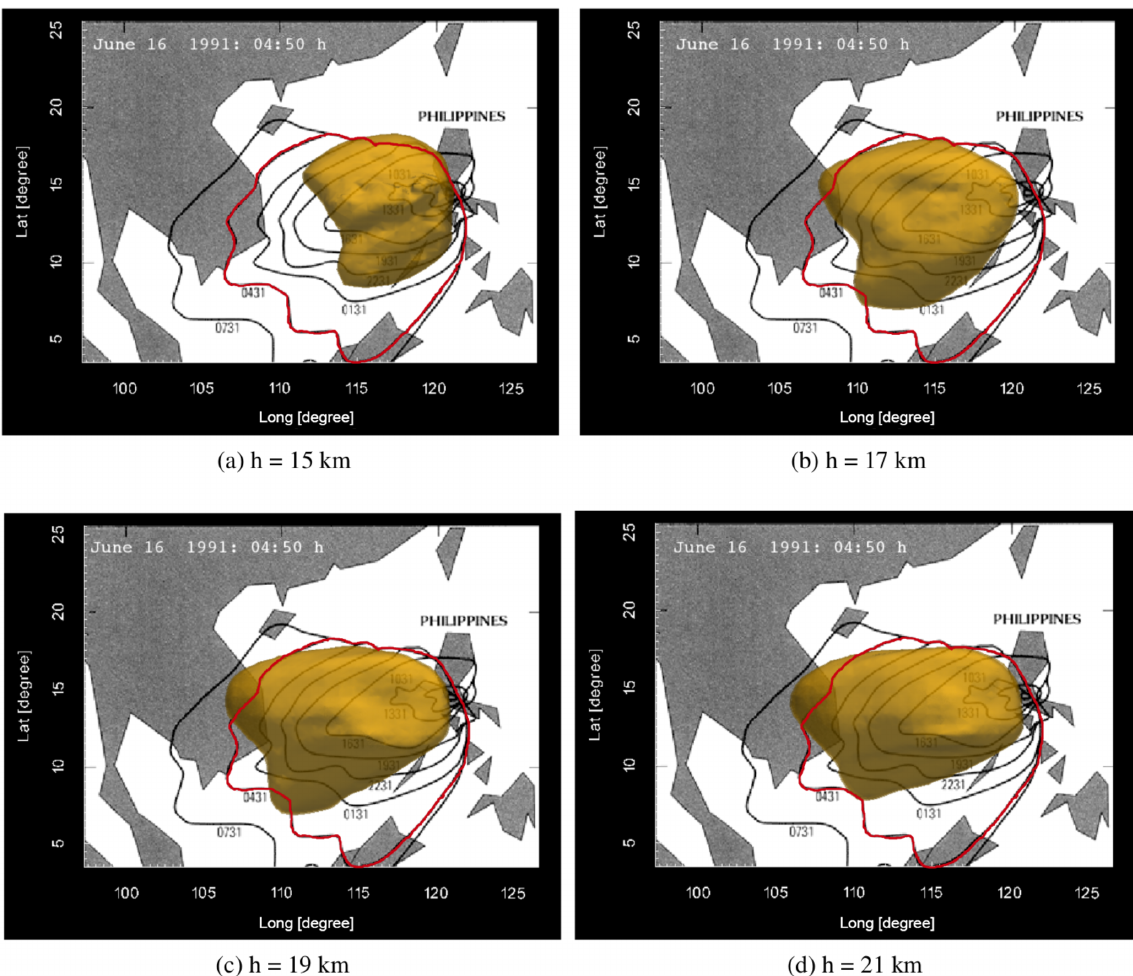
Figure 10. Advected ash cloud on 16 June 04:30 inserted at a mean height of 15, 17, 19 and 21km in combination with the extent of the observed ash cloud analyzed by Lynch and Stephens